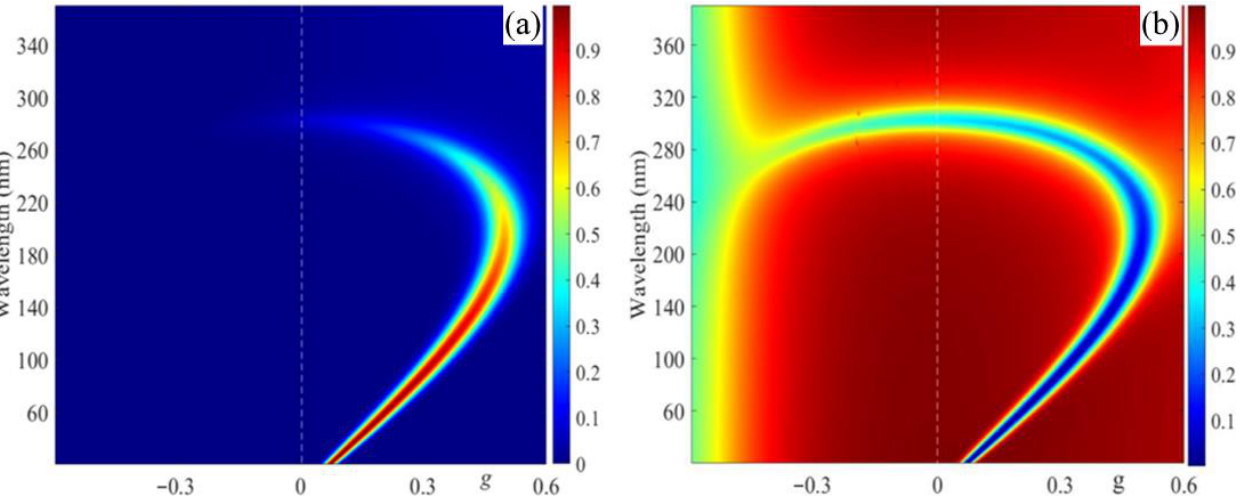
Figure 6. The evolution of the transmission ( a ) and absorption ( b ) spectra with a change in parameter g for incident light with polarization coinciding with its diffracting EP.